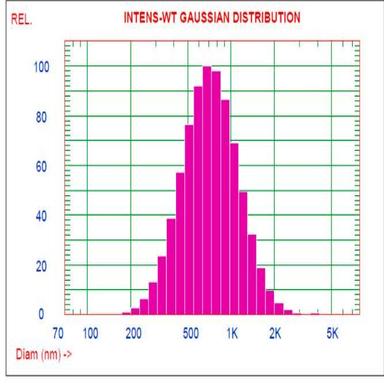
Cumulative particle size distribution of milled SiO2@C powders prepared from rice husk.